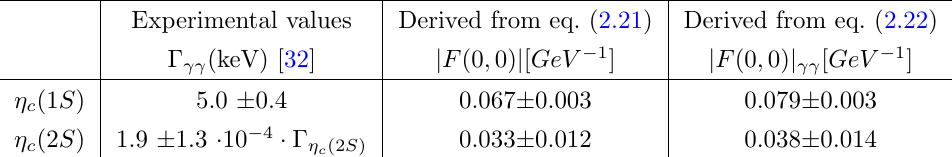
Table 2 . Radiative decay widths as well as j F (0 ; 0) j obtained from (cid:0) (cid:13)(cid:13) using leading order